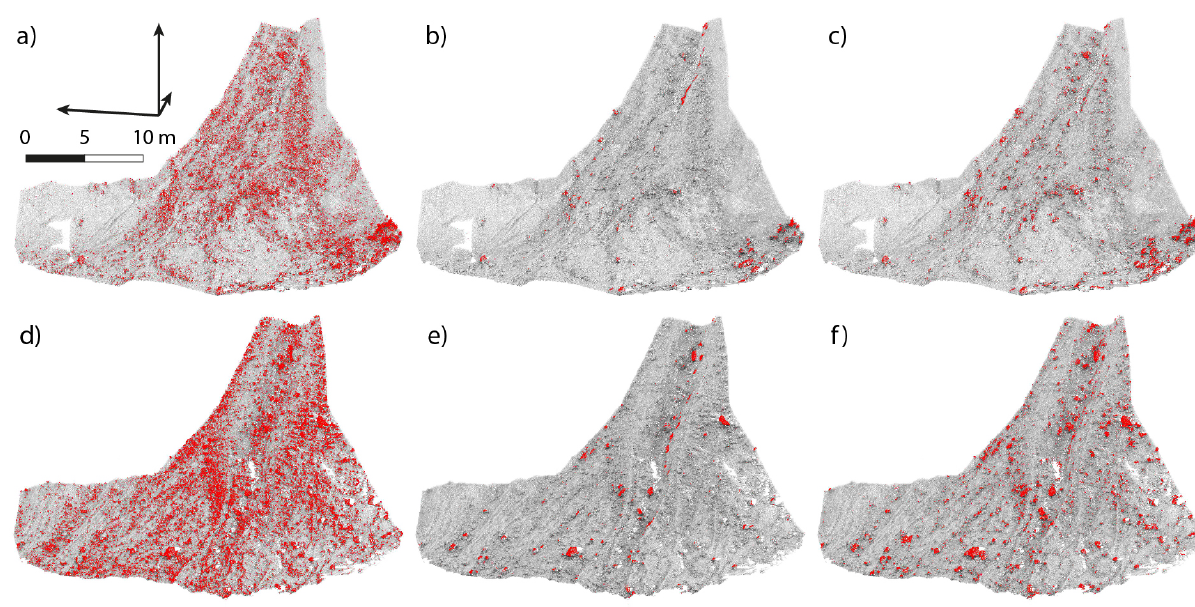
Figure 8. Comparison of the classified non-ground points (red) on the debris cone. Results are shown for the points clouds acquired in 2017 (a,b,c) and 2019 (d,e,f) filtered with the best parameter set using the PTD filter (a,d), the CSF (b,e) and the MCC